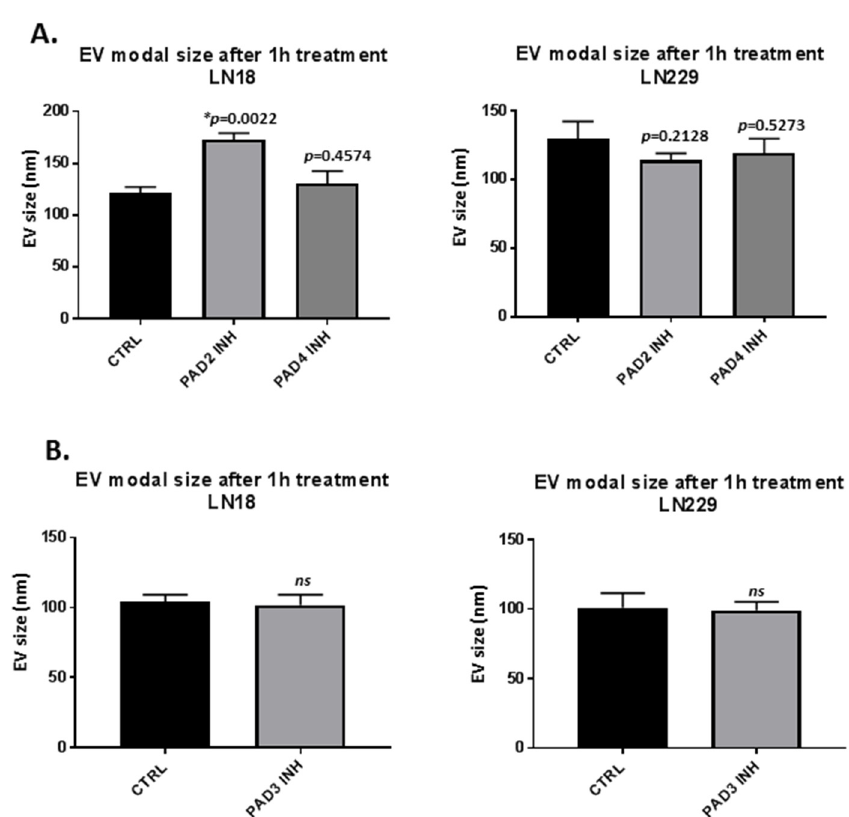
Figure 3. E ff ects of PAD2, PAD3 and PAD4 isozyme-specific inhibitor treatment on EV modal size in GBM cells, following 1 h treatment. ( A ) Modal size of EVs released from LN18 cells and LN229 cells, respectively, following 1 h PAD2 and PAD4 inhibitor treatment. ( B ) Modal size of EVs released from LN18 cells and LN229 cells, respectively, following 1 h PAD3 inhibitor treatment. Exact p -values are indicated, error bars show SD (* indicates significant di ff erences with p < 0.05; ns = non-significant change; n = 3 biological replicates for all).